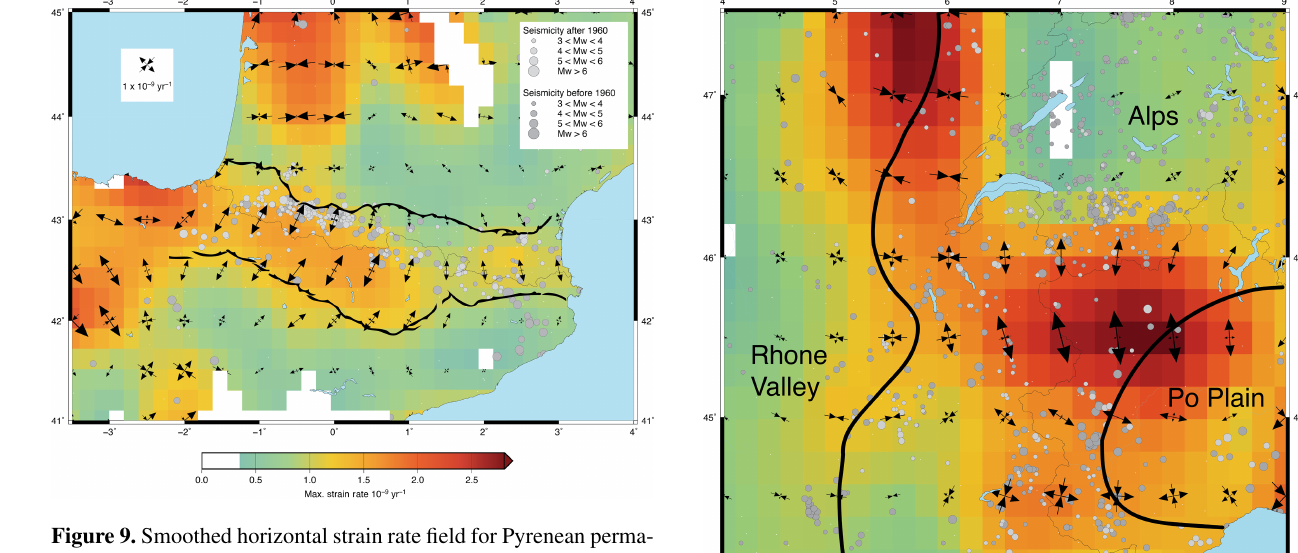
Figure 9. Smoothed horizontal strain rate field for Pyrenean perma- nent and campaign stations, with instrumental (dark gray) and his- torical (light gray) seismicity (SHARE and SI-Hex) and the main fault zones bordering the Pyrenees to the south and to the north.